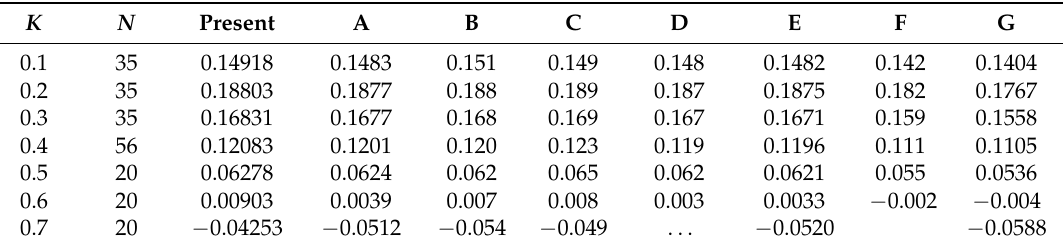
Table 2. Phase shifts η ( radians) e + -H scattering for various k and comparison with previous calculations.